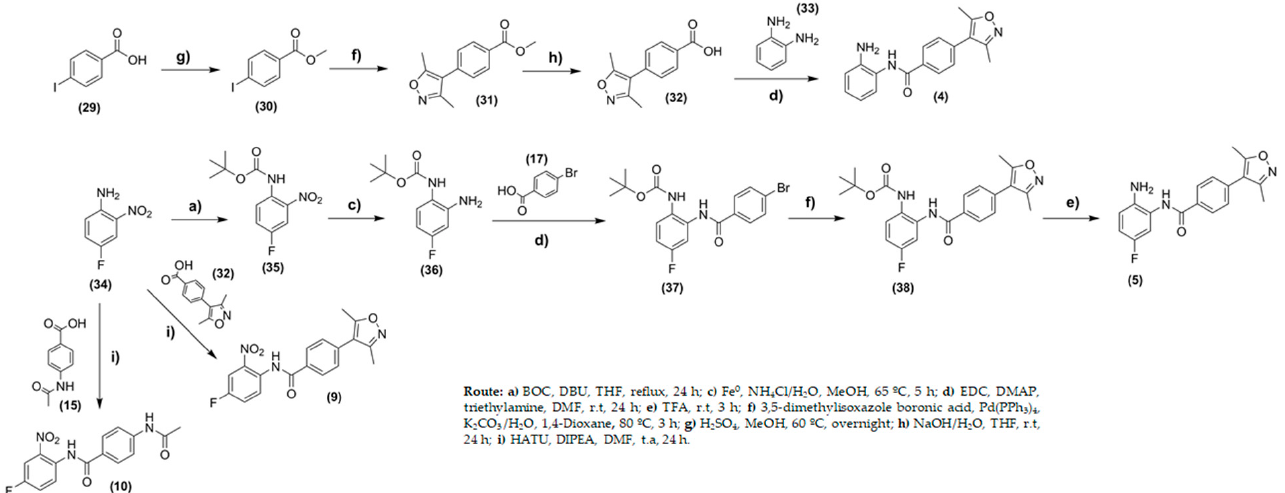
Figure 6. Synthesis of compounds ( 4 ), ( 5 ), ( 9 ), and ( 10 ).